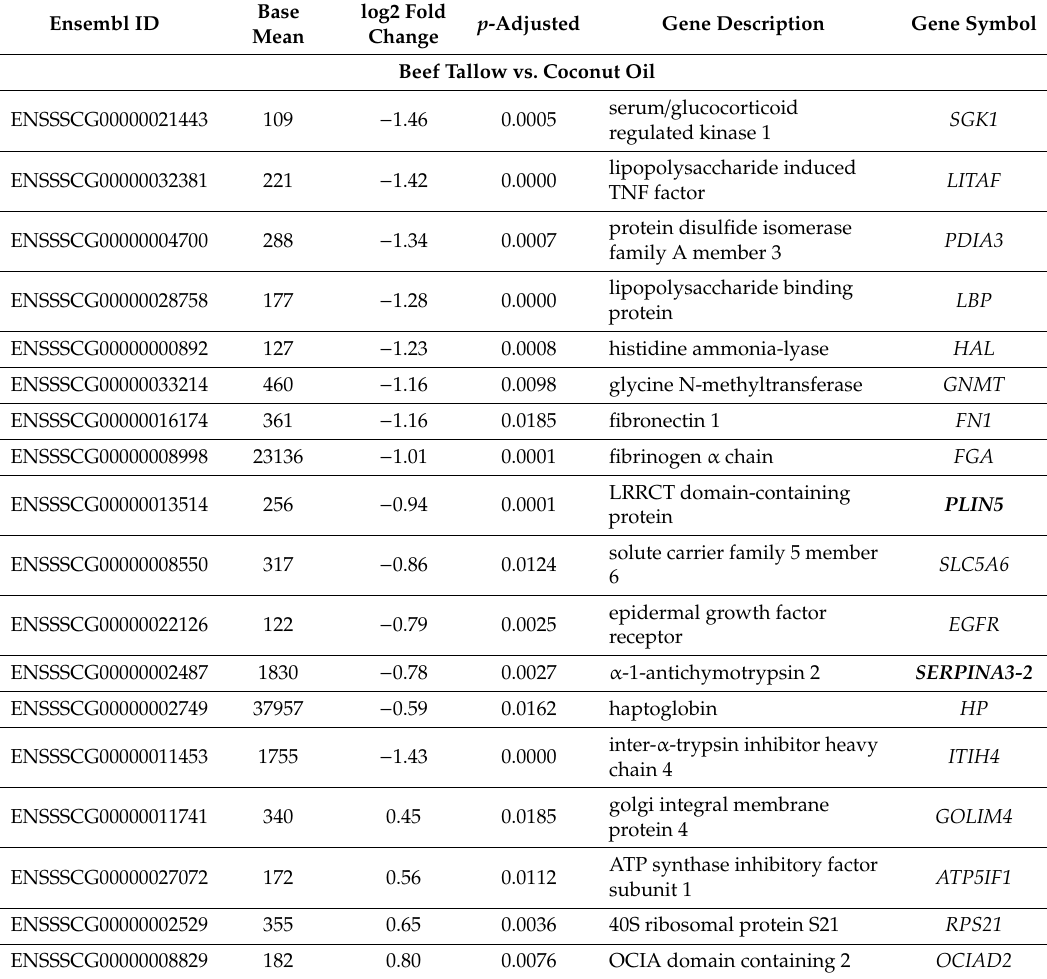
Table 2. Top 20 DEGs with the highest adjusted p -value for each